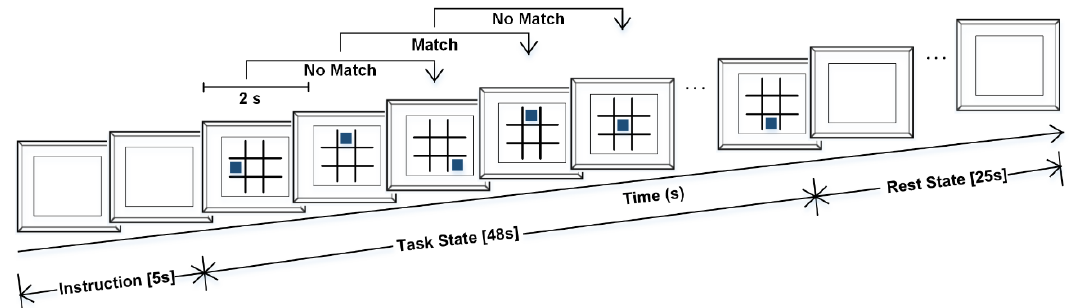
Figure 2. Positional 2-back test. Each event is 2 s long, and the task state lasts for 48 s. Afterward, a 25 s Rest state followed, when the subjects did not move and remained visually affixed to the blank computer screen.